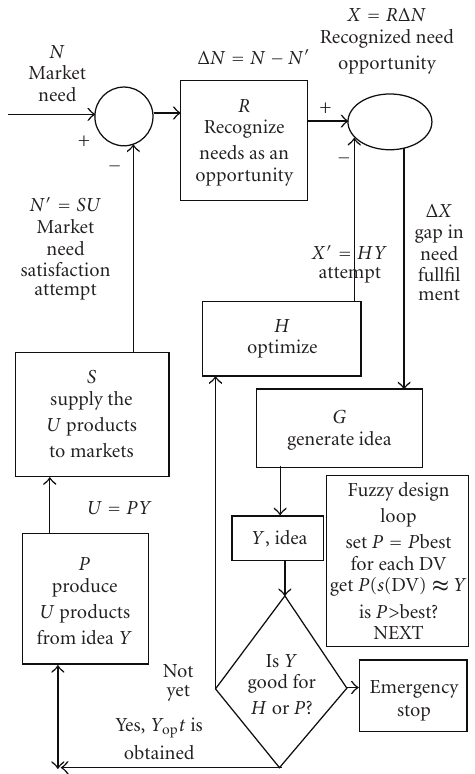
Figure 4: A typical design control loop for innovation tasks.